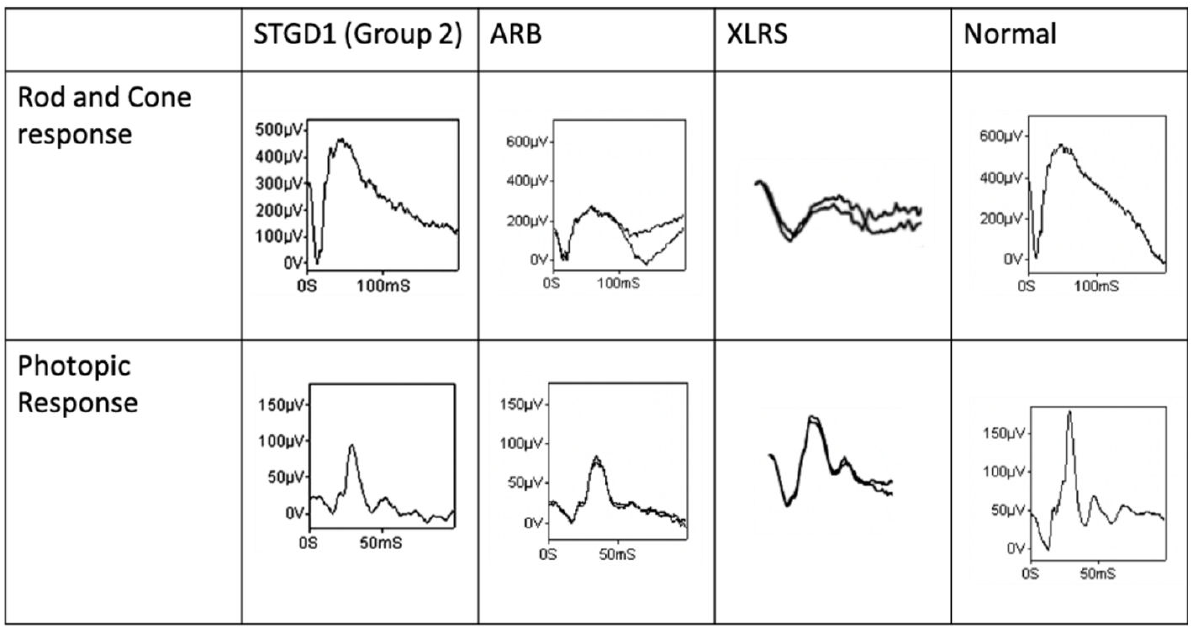
Figure 4. Abnormal ffERG waveforms of Stargardt disease (Group 2), autosomal recessive be- strinopathies, and X-linked retinoschisis compared to normal. The abnormalities of the ffERG waveforms caused by different extents of reduction in a- and b-waves under scotopic and photopic conditions are presented in these disorders (adapted from Fujinami et al. [26], Burgess et al. [50], and Sieving et al. [58] with